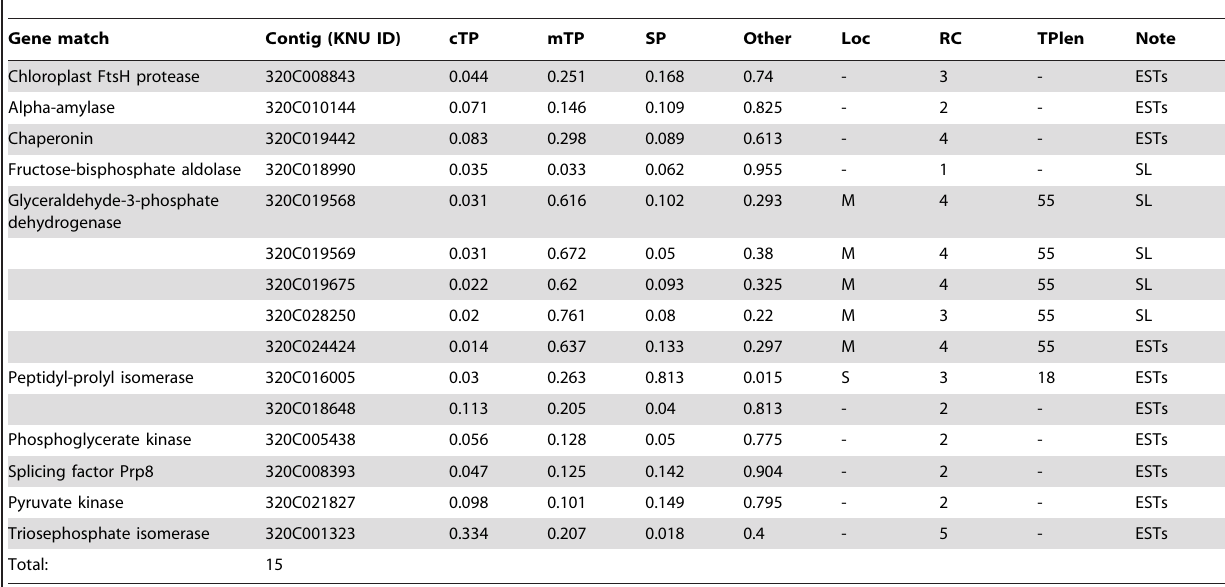
Table 3. List of contigs used for 5 9 -RACE and prediction of sub-cellular